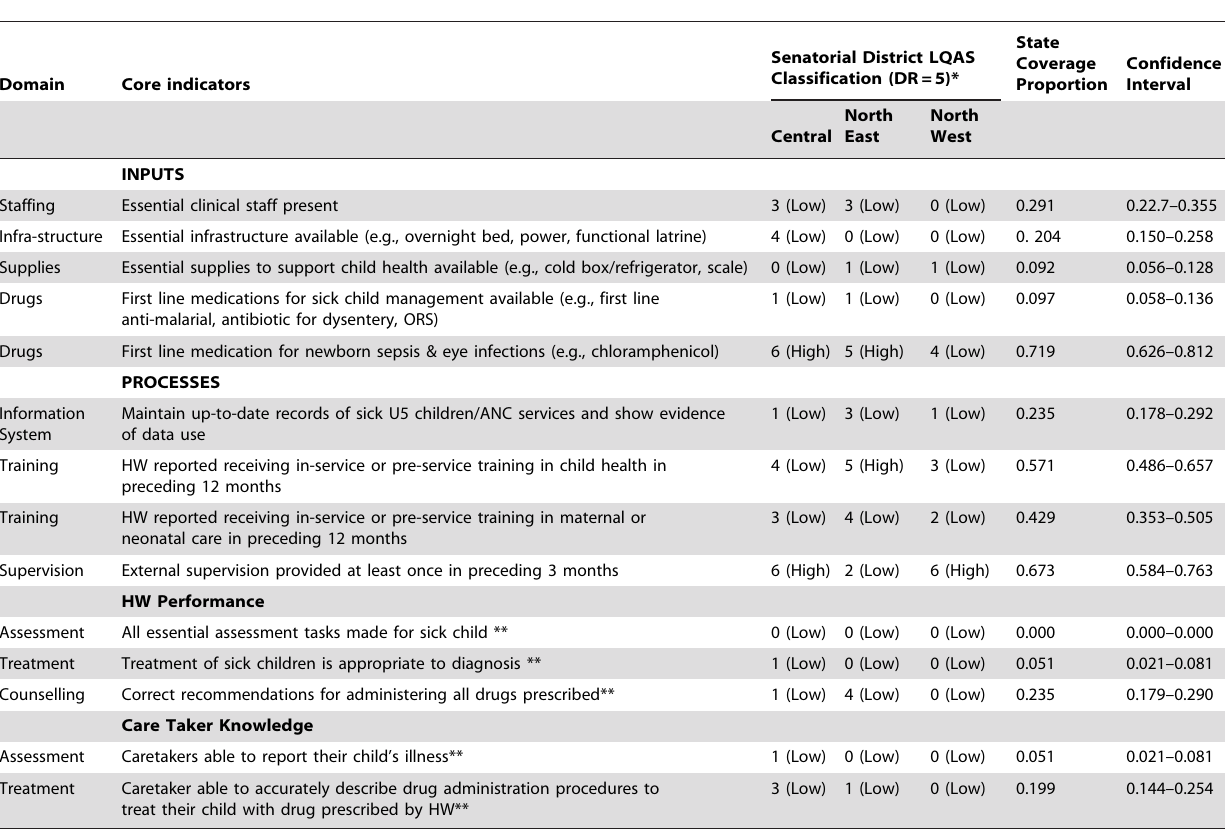
Table 2. LQAS Classification of Health Facilities by Core Indicators in the Senatorial District of Jigawa and Coverage at the State Level during